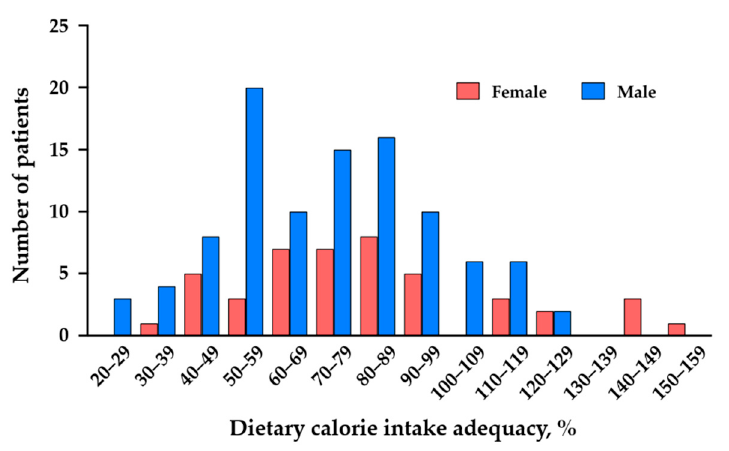
Figure 1. Distribution of dietary calorie intake adequacy rate of the female and male patients with chronic HF.